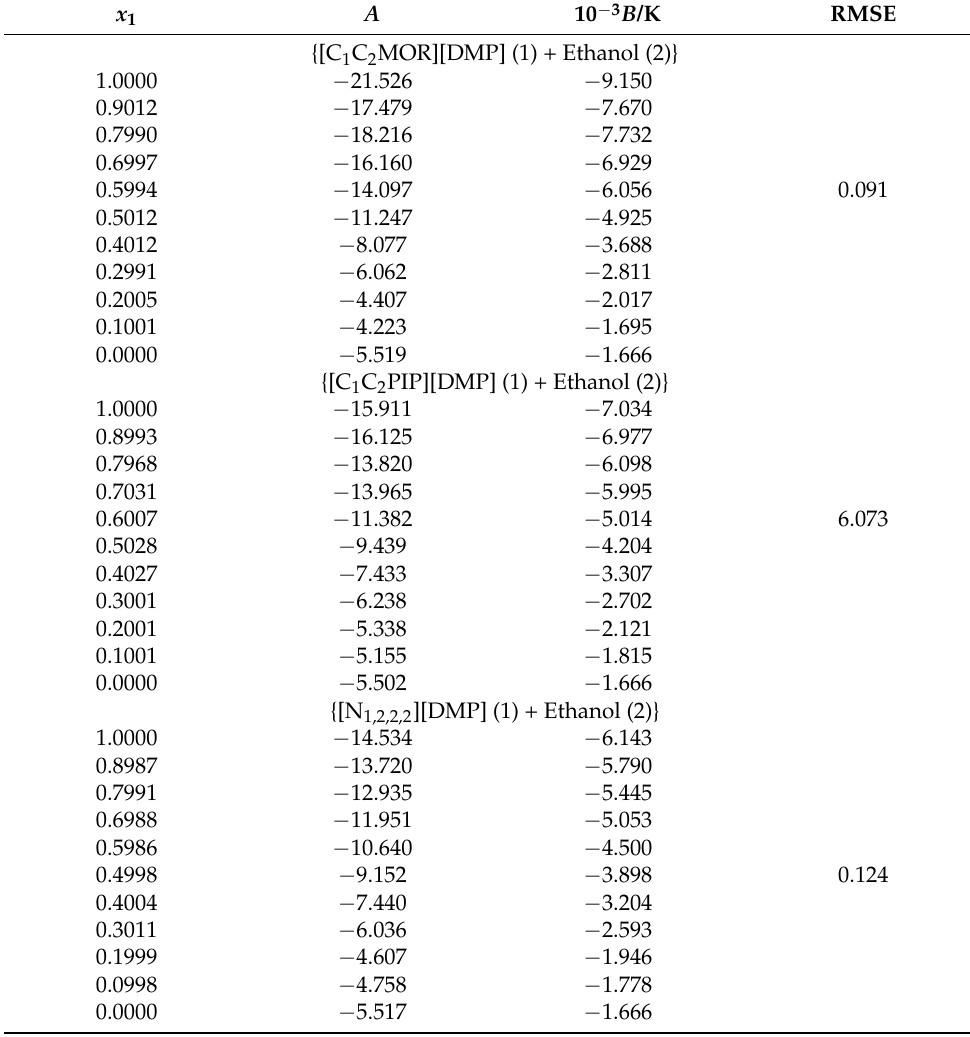
Table 12. The parameters of Equations (19) and (21) for correlation the temperature dependence of the dynamic viscosity of {IL (1) + Ethanol (2)} binary systems a . x